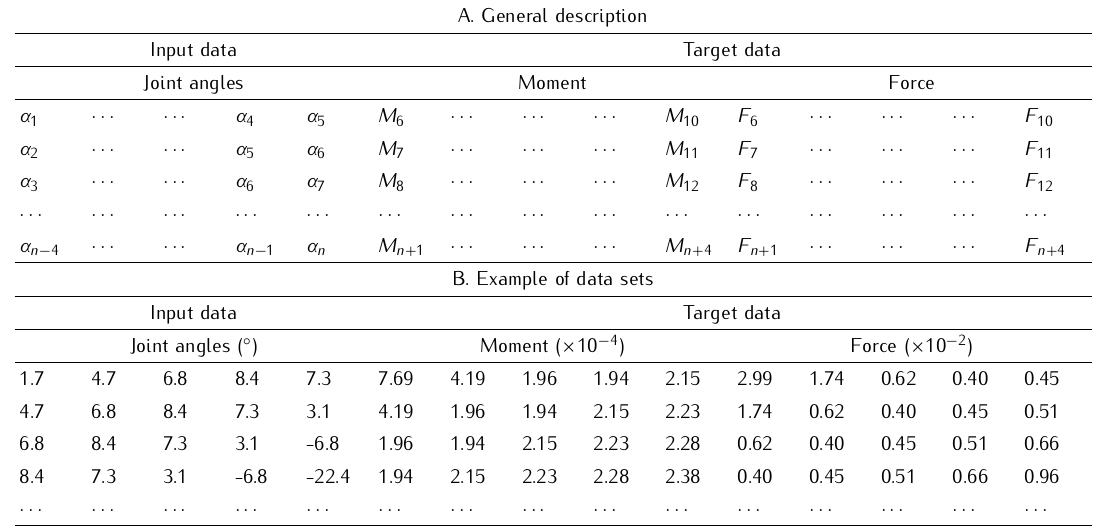
Table 2. Table of training data of five past states of joint angle, five expected states of the muscle moment and five expected states of the muscle force.